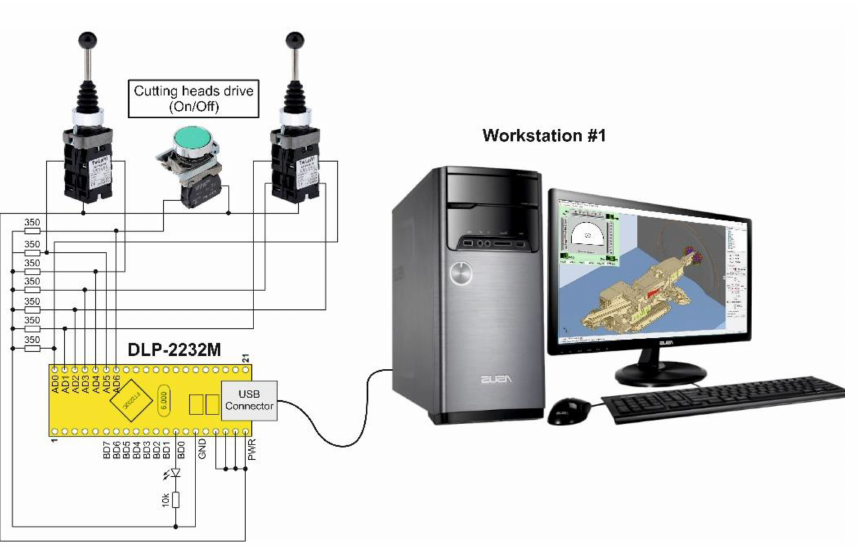
Figure 12. Schematic diagram of the communication interface between the Operator Station and Workstation #1 with the RH-Sim _simulator